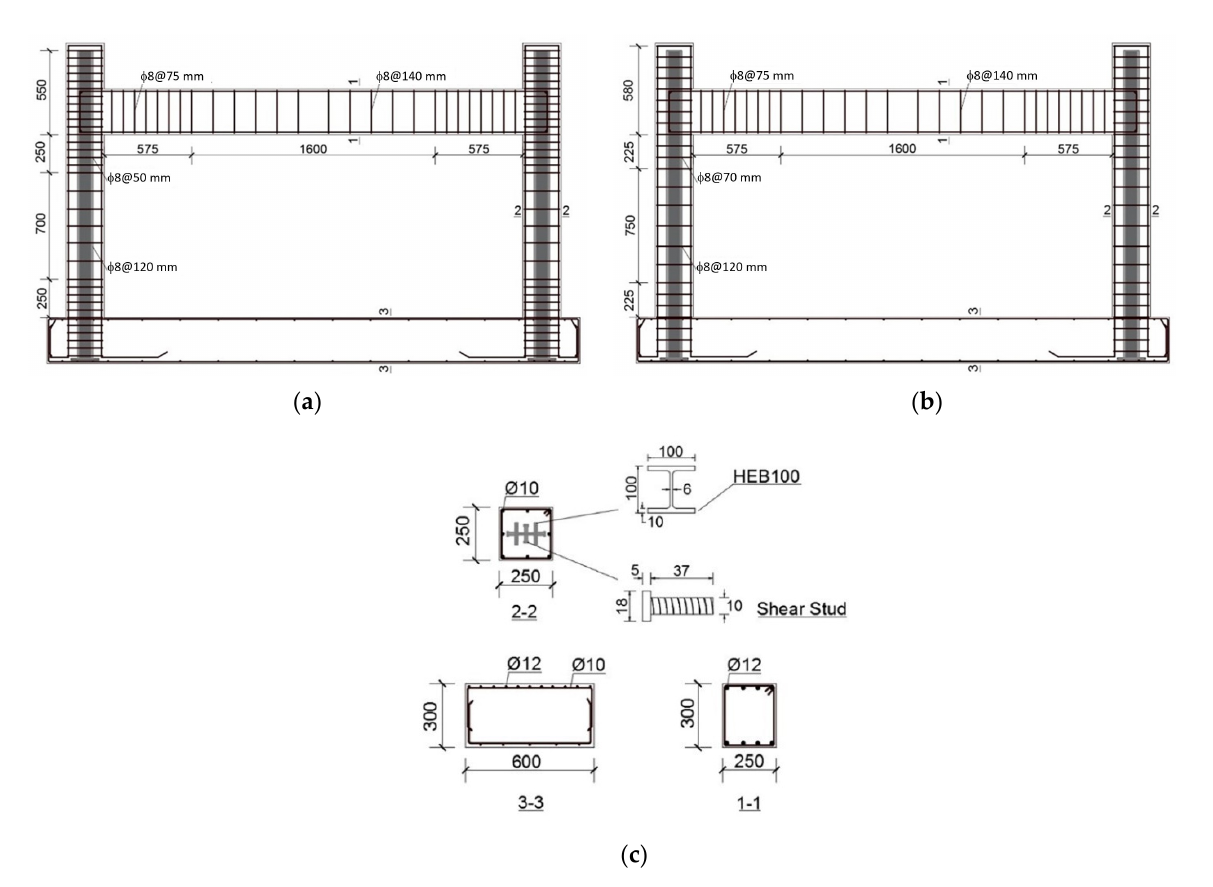
Figure 1. General layout of tested frames: ( a ) Side view; ( b ) top view [24].